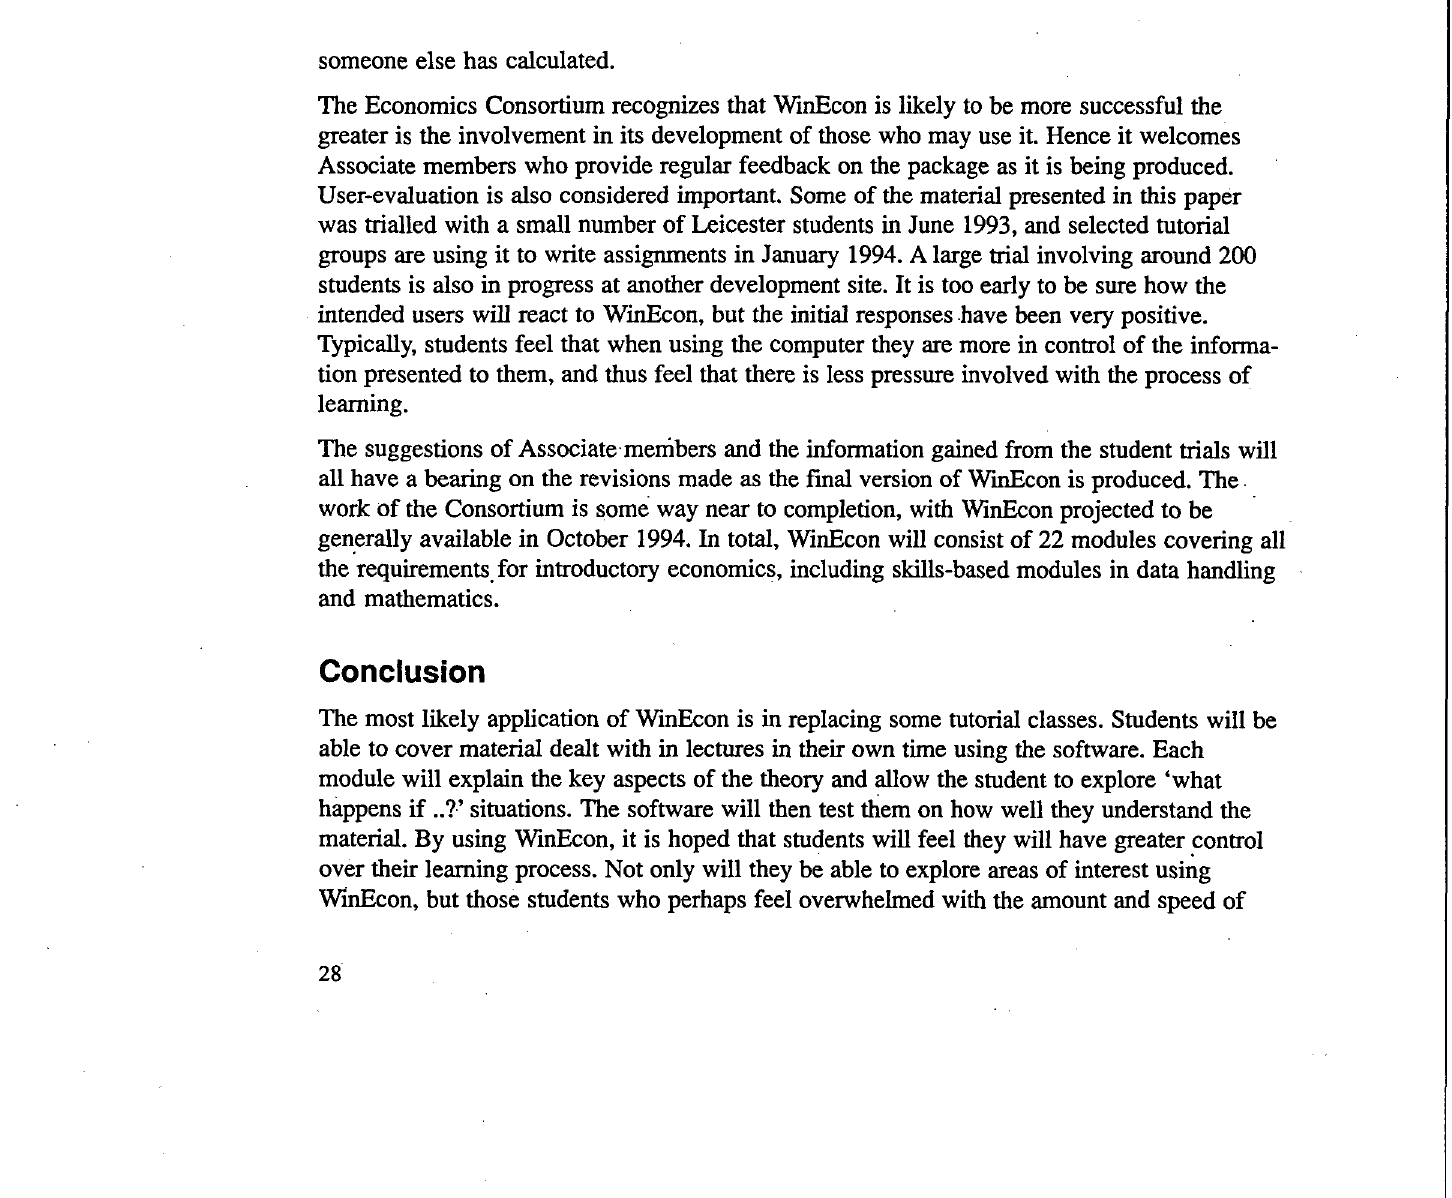
Figure 12: Stepping through the analysis with multiple choice